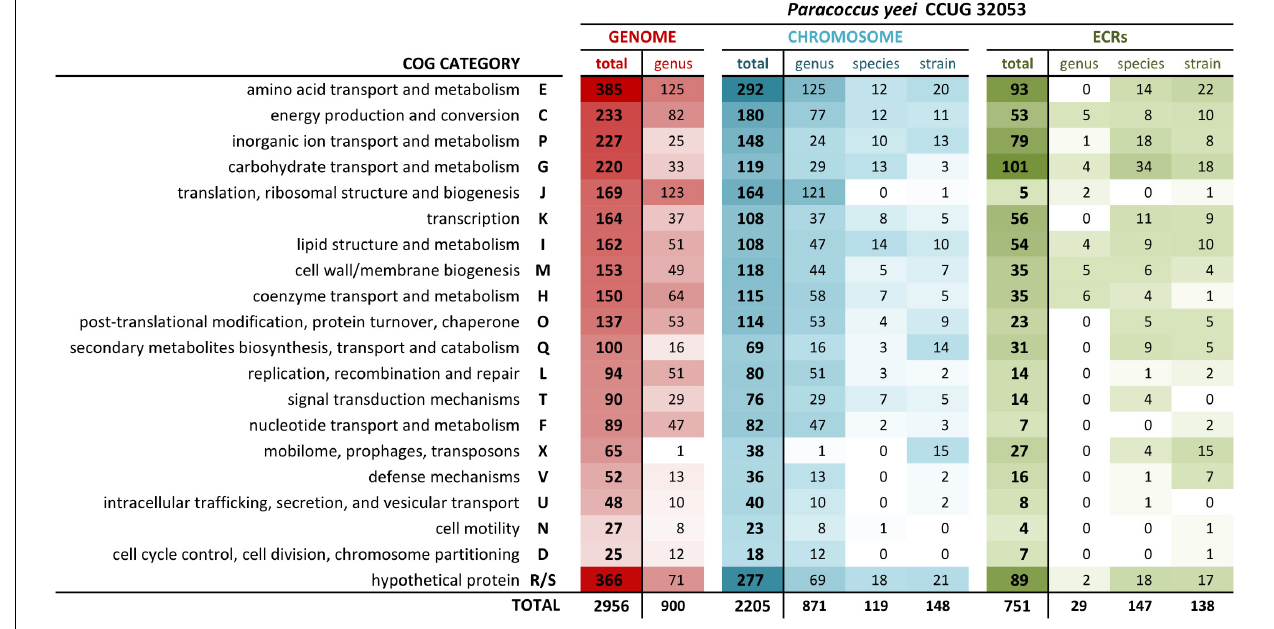
FIGURE 2 | Distribution of COG functional categories within the CCUG 32053 genome, the core genome of the genus Paracoccus as well as species- and strain-specific pools of